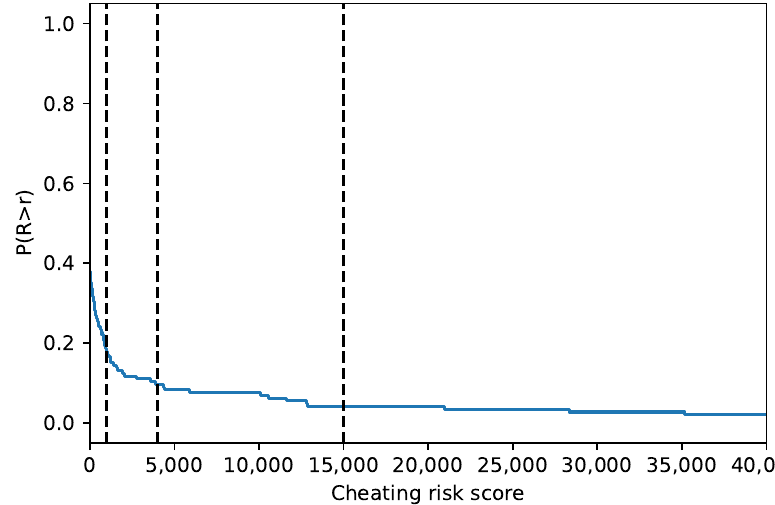
Figure 15. Survival function of cheating risk